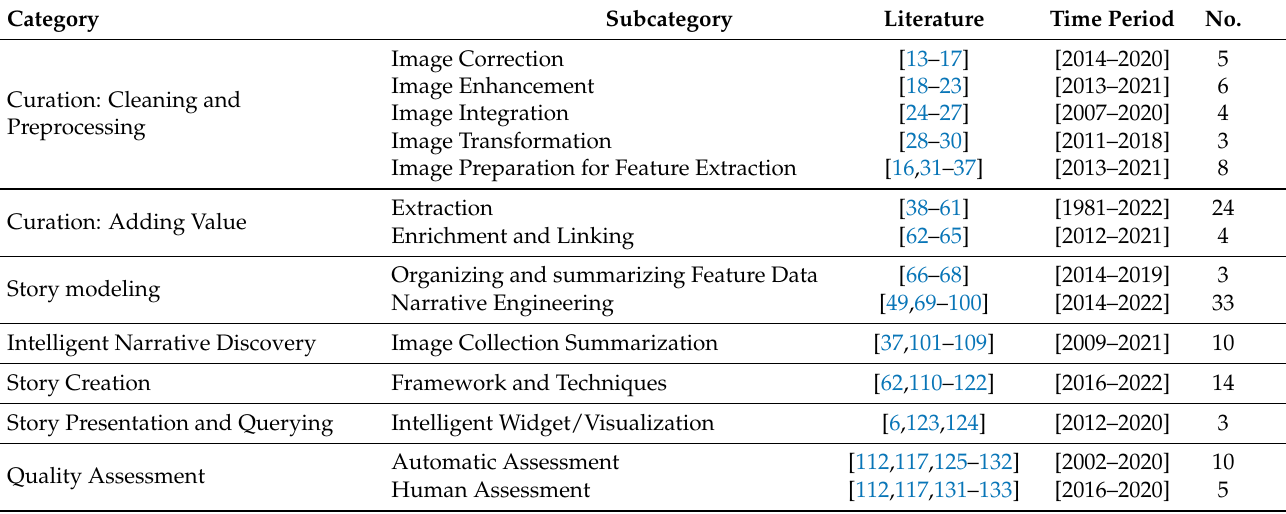
Table 2. Classification of selected papers in this survey.